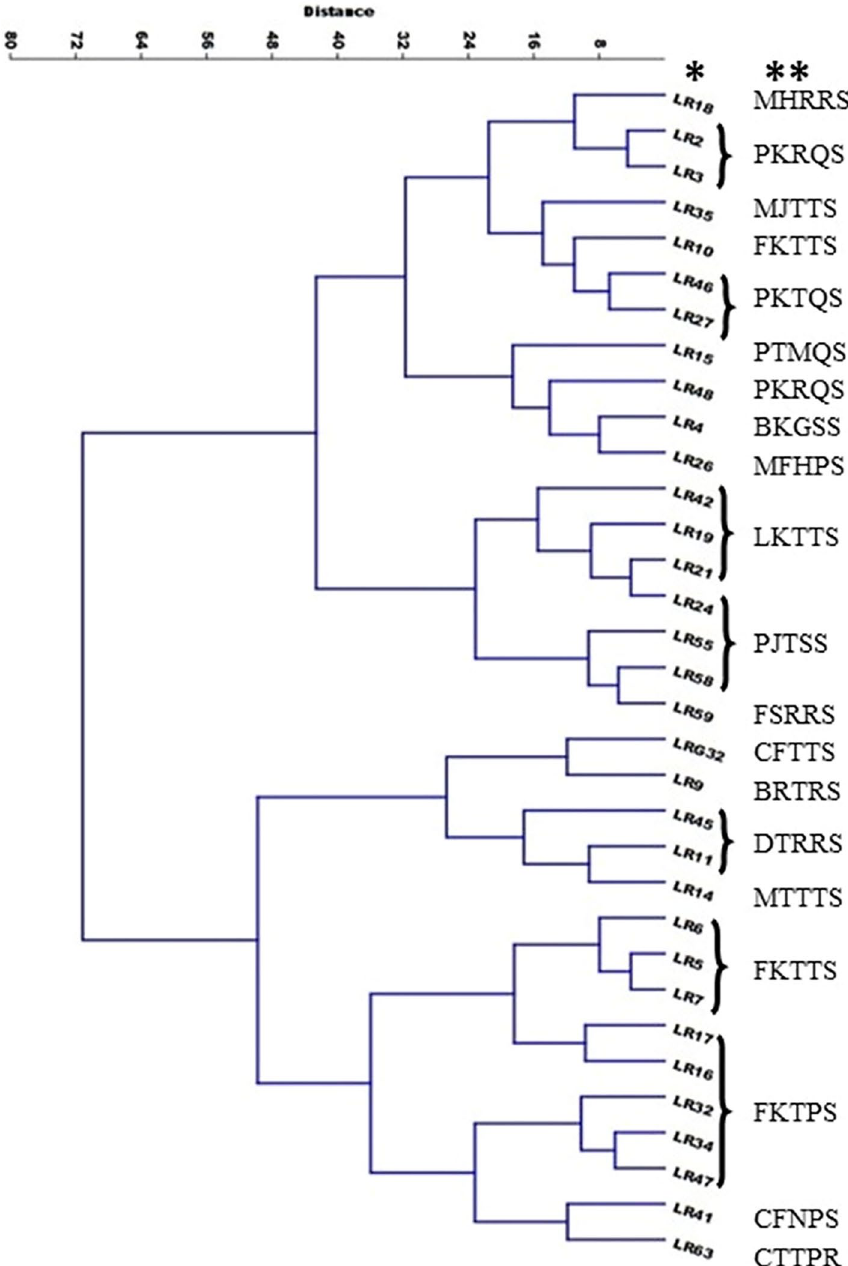
Figure 2. Cluster analysis of 33 isolates according to their virulence spectrum on 55 wheat differentials resulted in several clusters and sub-clusters. Note that the majority of isolates belonging to similar races are grouped in distinct clusters or very close sub-clusters. * Leaf Rust isolates, ** Identified physiologic